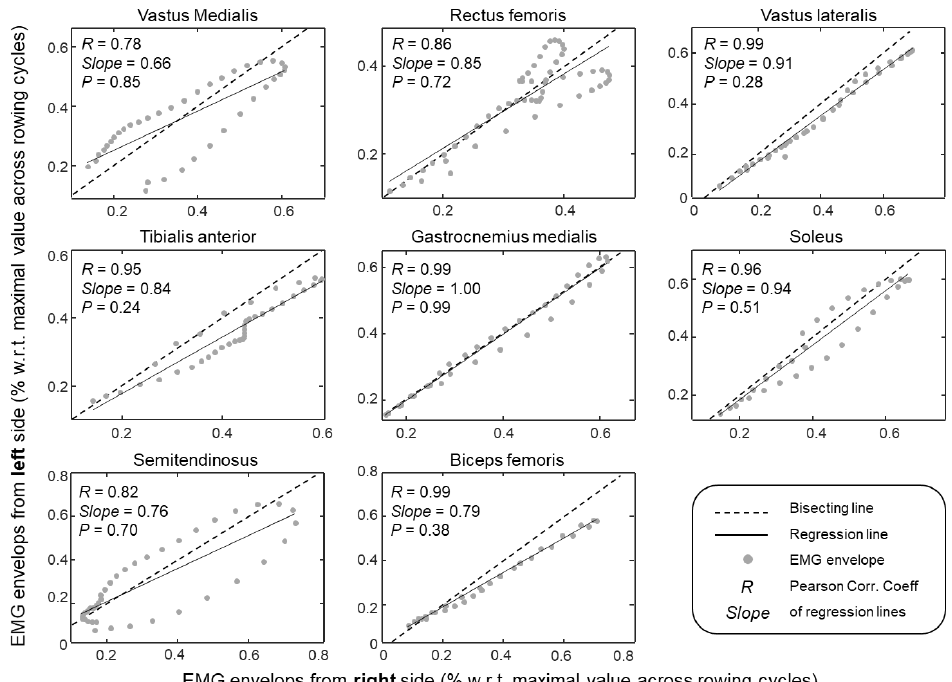
Figure 4. Scatter plots created from EMG envelopes (circles) obtained for periods within which muscles were active and averaged across subjects. Envelopes obtained for the left and right sides are respectively plotted along the ordinate and abscissa. Pearson correlation coefficients ( R values) and the slope of regression (black continuous) lines are shown within each panel. Bisecting (black dashed) lines are also shown to readily indicate how much the slope of regression lines differed from unity (P-values within the plots indicate whether this difference is statistically significant).